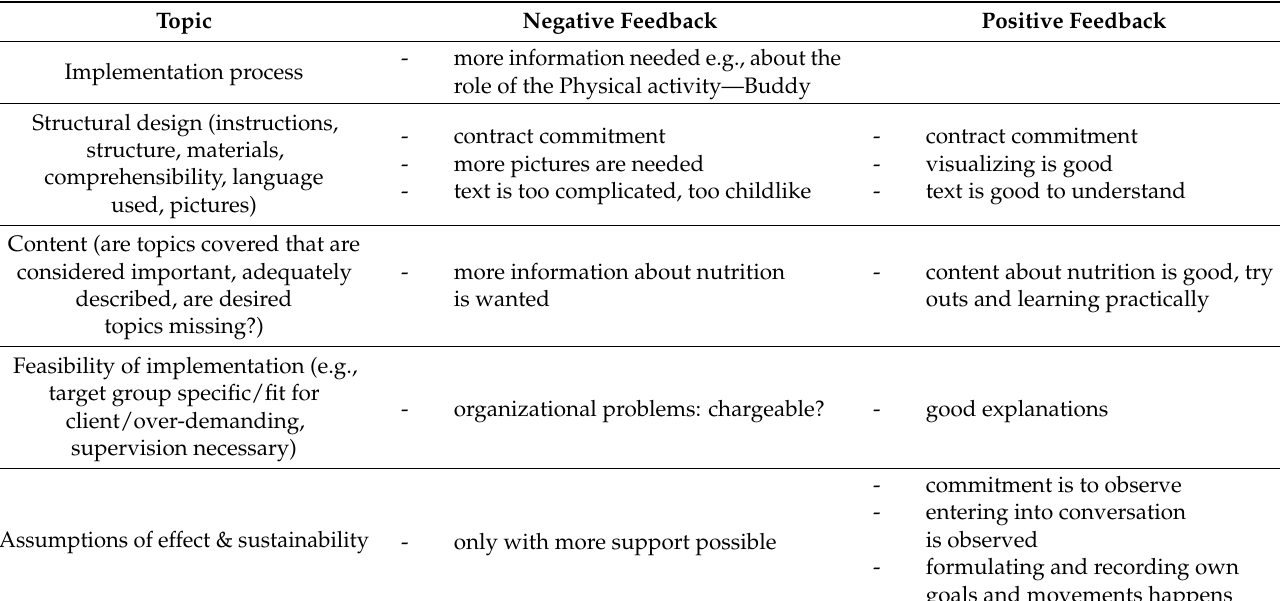
Table 3. Overview: results of testing the